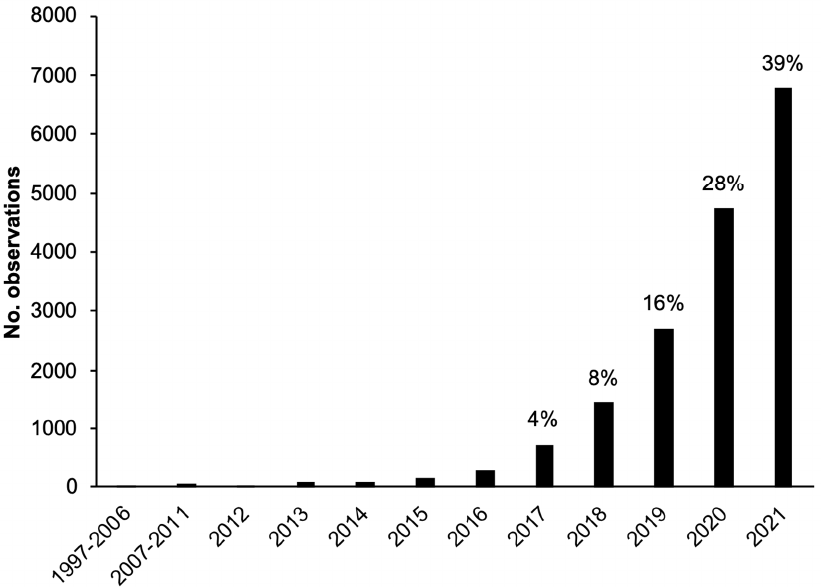
Figure 1. Number of iNaturalist tick observations in the study area separated by year. The percentage of total tick observations for each year is labelled above each bar for